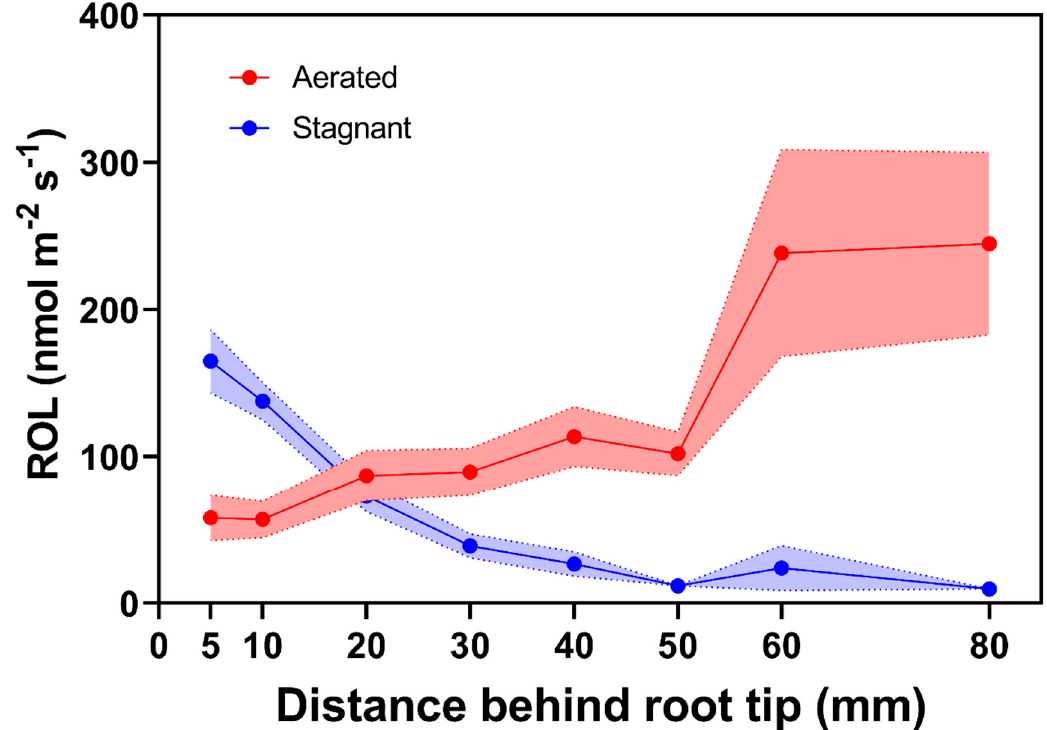
Figure 1. Radial O 2 loss from individual adventitious roots of rice grown in aerated or stagnant, deoxygenated conditions. In aerated nutrient solution, rice does not form an ROL barrier (with the exception of some wild accessions [20]), whereas the barrier is formed in stagnant, deoxygenated nutrient solution. Points indicate mean radial O 2 loss at different distances behind the root tip and bands represent standard error (figure was constructed compiling published information on ROL from rice roots [11–20], n = 28). Plants were grown in aerated or stagnant, deoxygenated conditions for 5 to 31 days. Lengths of the roots were 93 to 159 mm.